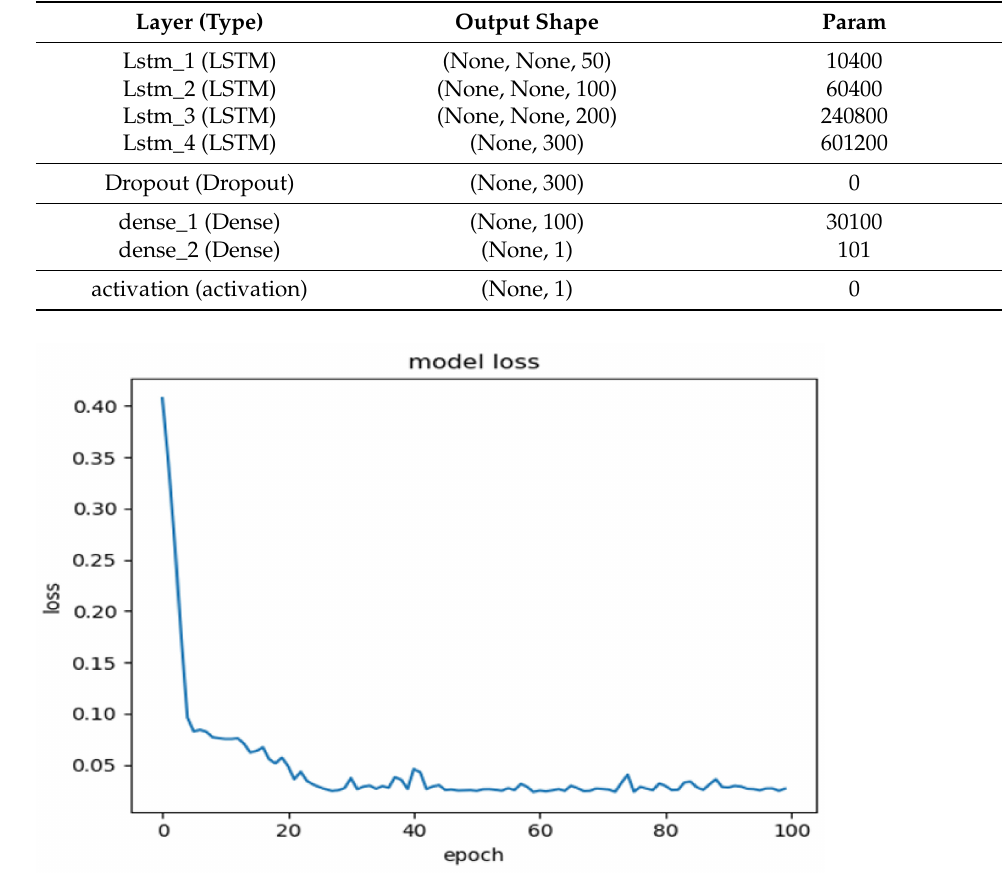
Figure 11. Error changes during model training.